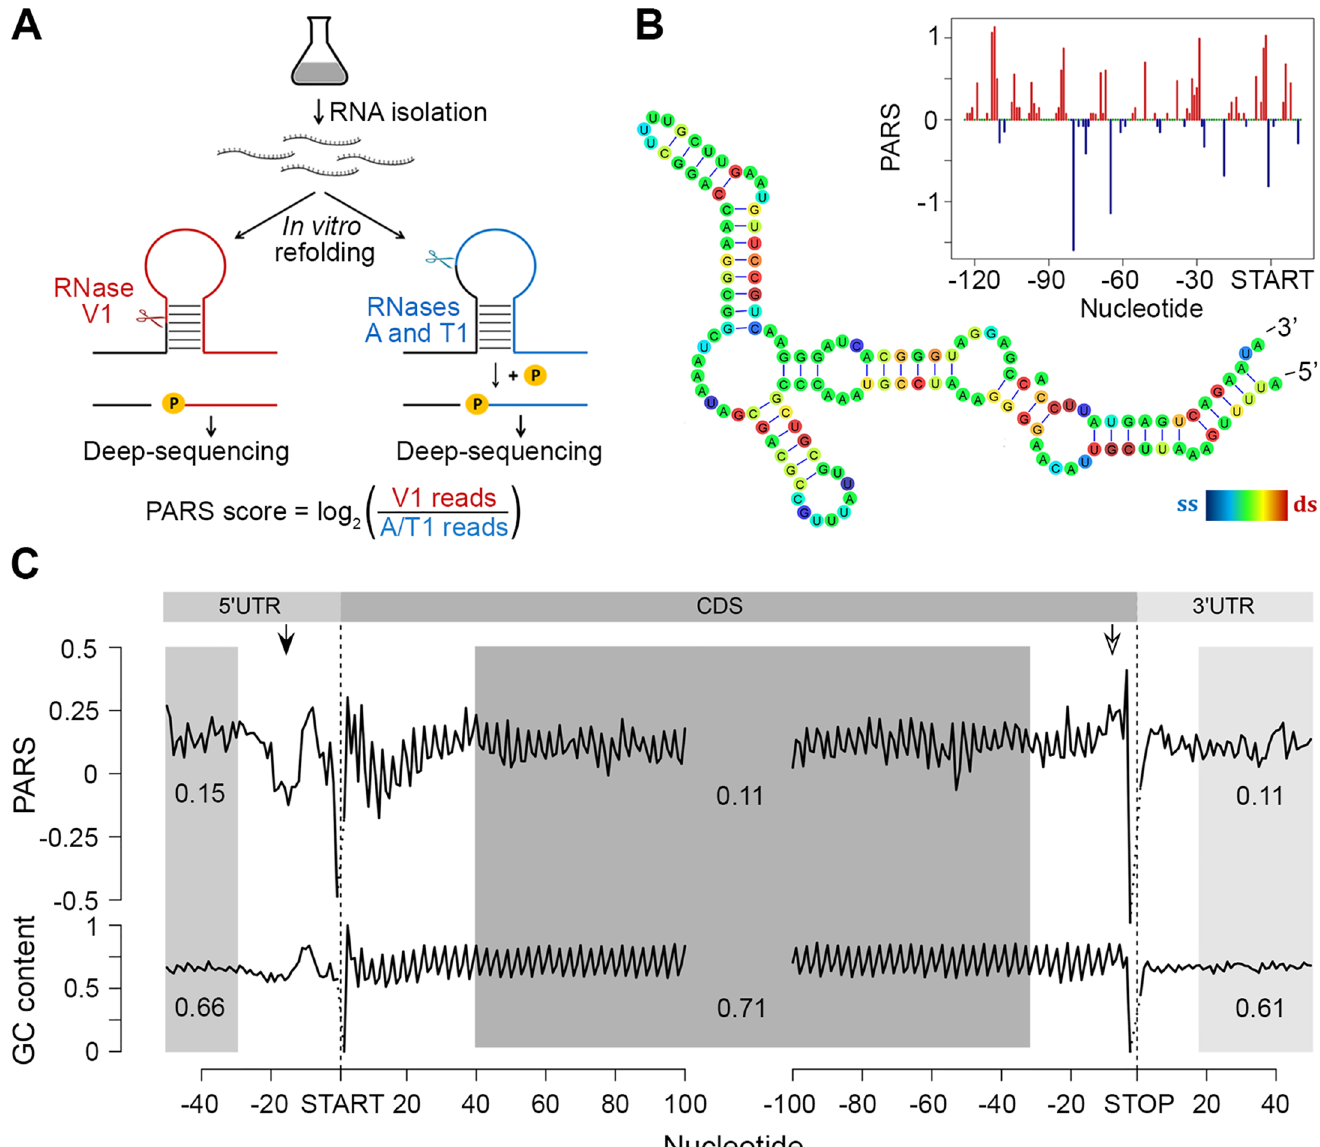
Fig 1. PARS analysis. (A) Overview of modified PARS approach. RNase V1 cleaves double-stranded RNA and combination of RNases A/T1 the single stranded RNA with optimal activities at physiological pH (7.0). RNAse A/T1 usage requires an additional phosphorylation step prior to library generation. (B) The PARS score of the rpoS leader sequence (inset) was overlaid with the experimentally determined structure [64]. Double-stranded nucleotides with positive PARS score are colored red, single-stranded nucleotides with negative PARS score – blue, nucleotides with missing PARS score or equal to zero – green. The color intensity of the rpoS nucleotides reflects the PARS scores (rainbow legend). (C) Metagene analysis of protein-coding transcripts. Average PARS score for each nucleotide (top) and GC content (bottom) across the 5 ’ UTRs, CDS and 3 ’ UTRs of all protein-coding transcripts, aligned at the start or stop codon, respectively. For the shaded areas the average PARS scores or GC content is calculated; thus note the deviations from the total GC content of 51% in E . coli . Unstructured region upstream of the start codon and structured sequence preceding the stop codon are marked by arrows with filled and open arrow heads,